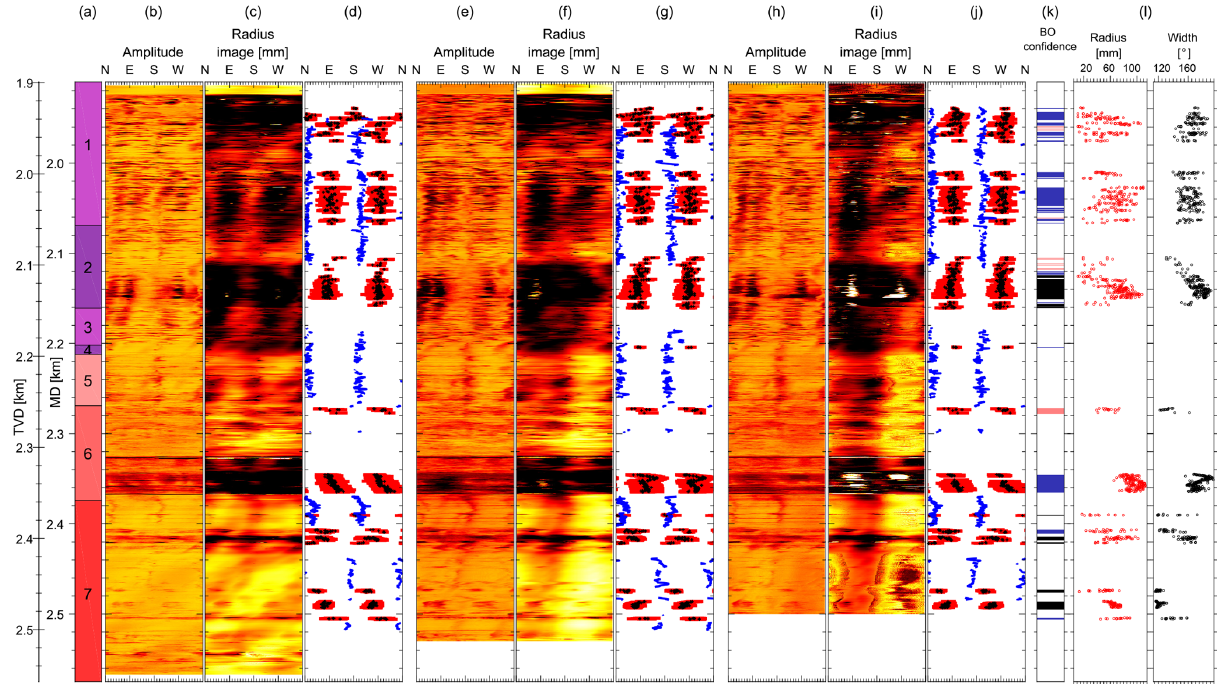
Figure 2. Synthesis of the data used in this analysis of borehole GRT-1. The measurements are expressed as a function of measured depth (MD) and vertical depth (TVD). (a) Simplified lithologic column: (1) Couches de Rehberg, (2) Couches de Trifels, (3) Annweiler sandstone, (4) Permian layers older than Annweiler sandstone, (5) rubefied granite, (6) hydrothermally altered granite and (7) low altered granite. The UBI images are presented, as are the data picked from the visual analysis of the double transit time image for the datasets for 2012 (b, c, d) , 2013 (e, f, g) and 2015 (h, i, j) collected in GRT-1. The radius of the borehole computed from the double transit time image is displayed in panels (b)–(e) and (h) . In panels (d)–(g) and (j) , blue dots represent the azimuth of the drilling-induced tension fractures (DITFs), black dots represent the azimuth of the maximal radial depth of the breakouts and red bars represent the extension between the edges of the breakouts. Panel (k) presents information about the breakout (BO) confidence level applied to these results. Panel (l) summarizes the width (black dots; ◦ ) and the enlargement radius (red dots; mm) measured in the 2012, 2013 and 2015 images. Table 1. Data acquired in GRT-1 and GRT-2 and the specificities of UBI acquisition programs.